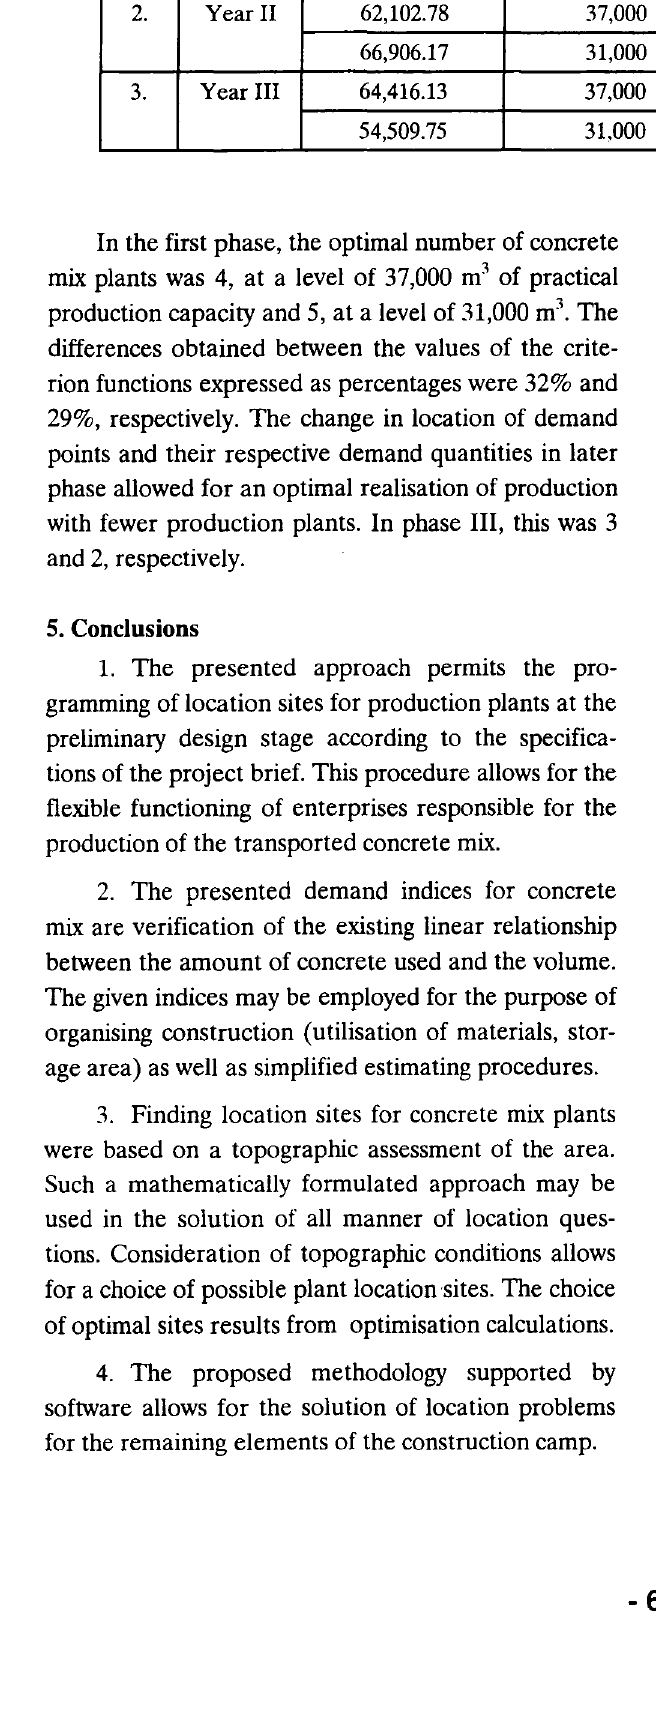
Table 1. Results of optimal situations Time Values of the Cri- Level of Practical Optimal Number Percent Differences Periods terion Function Production Capacity of Production Between Values of No